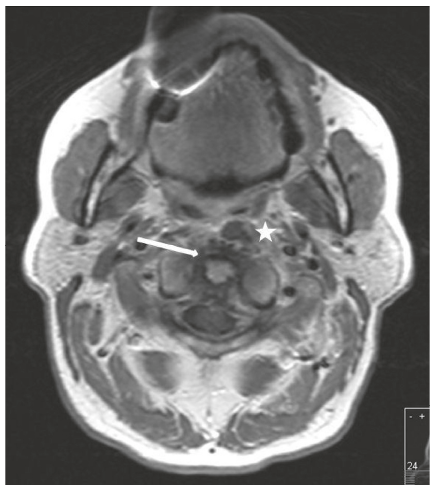
Figure 1: Axial MRI slice at initial presentation: contrast-enhanced T1-weighted axial MRI scan at the level of the dens axis. The white arrow identifies an annular enhancement round the dens axis while the white asterisk indicates the focus ventromedial of the left arch of the Atlas with 11 × 8mm in